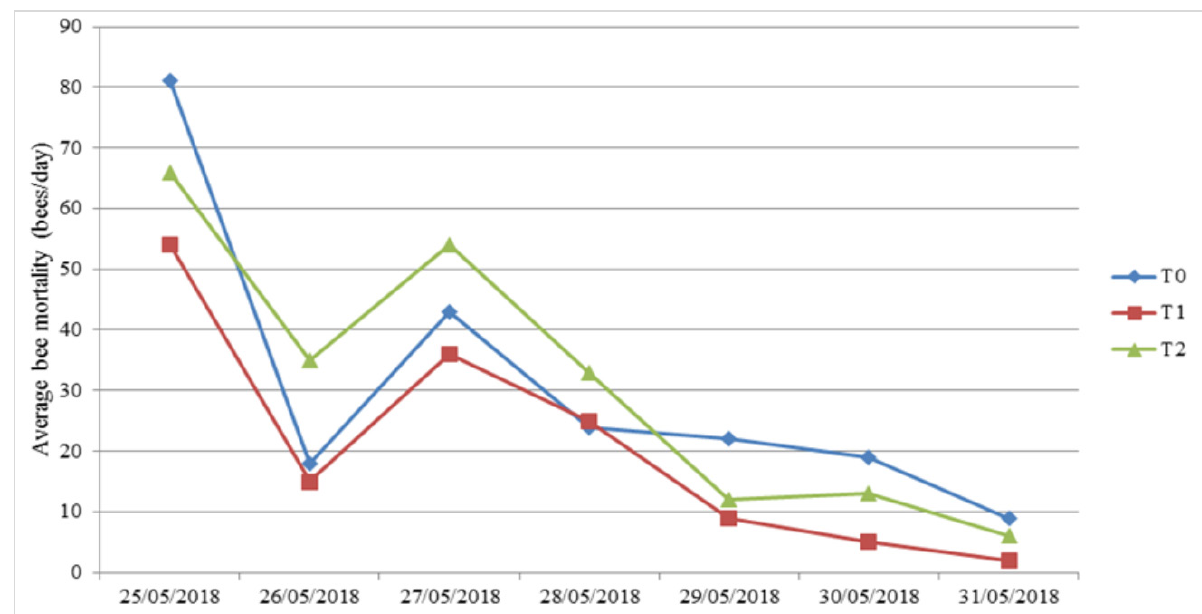
Fig 2 . Average daily mortality of honey bees not transported (T0) and submitted to transport for 1 hour (T50) and 2 hours (T100).